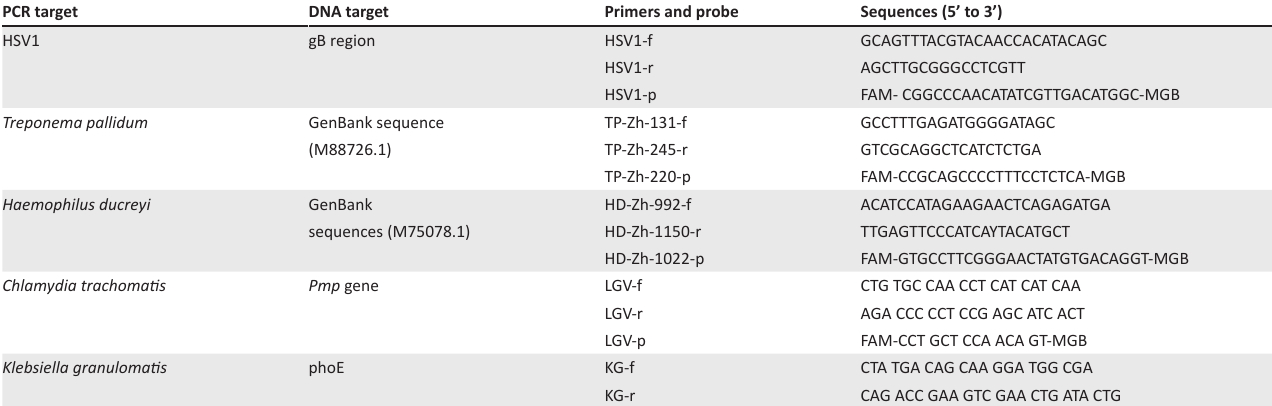
TABLE 1: List of primers and probes used to detect ulcerating pathogens in the study. PCR